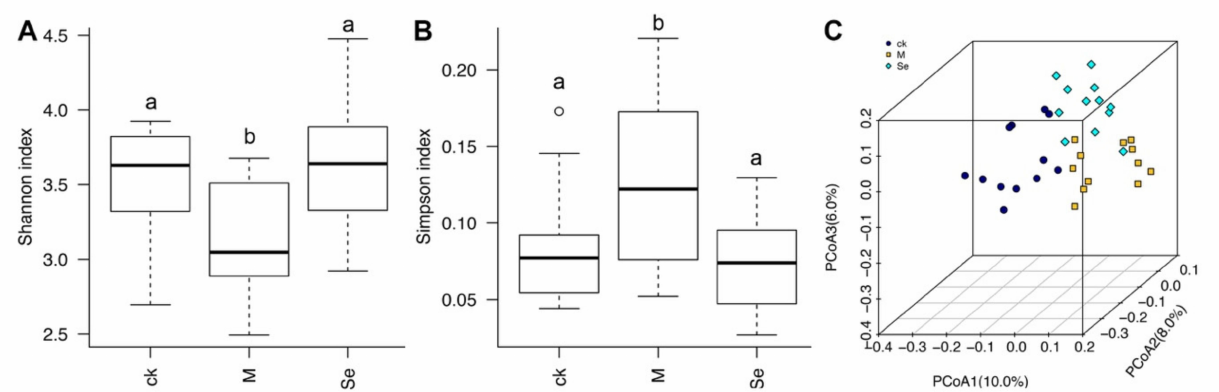
Figure 4. Effects of SeMet on the ( A , B ) α -diversity and ( C ) β -diversity of gut microbiota in mice. The same letter within each column indicates no significant difference ( p > 0.05). CK is short for the control group, M is short for the model group, and Se is short for the SeMet-treated